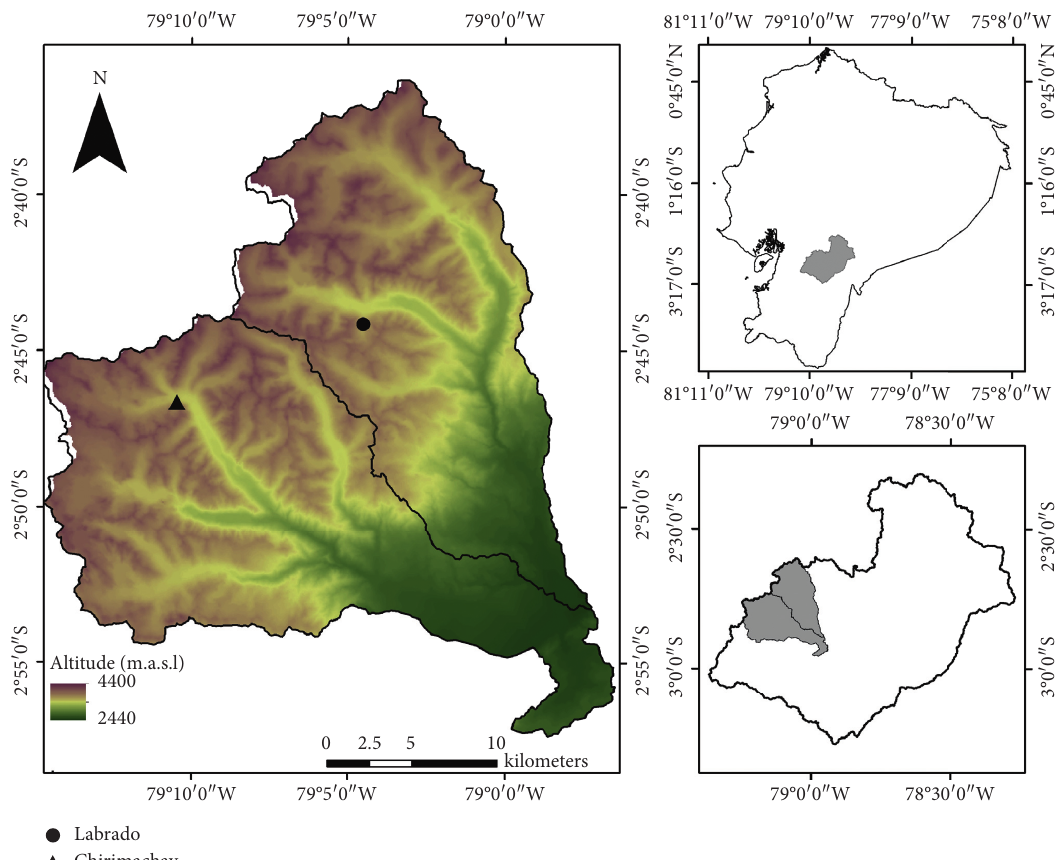
Figure 1: Location of the study area made up of the subbasins Mach´angara and Tomebamba.